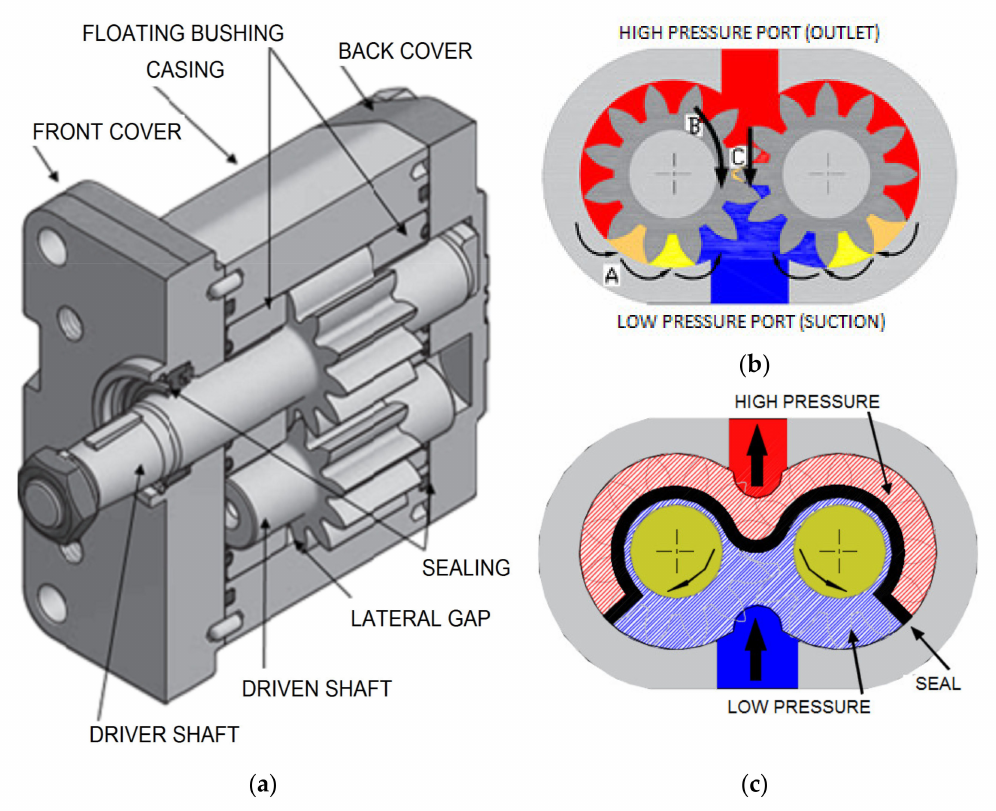
Figure 1. Exploded view of an external gear pump: ( a ) components of a pump (Source: ROQUET Group, S.A.); ( b ) leakage paths; ( c ) back side of the bushing (adapted from Torrent et al.